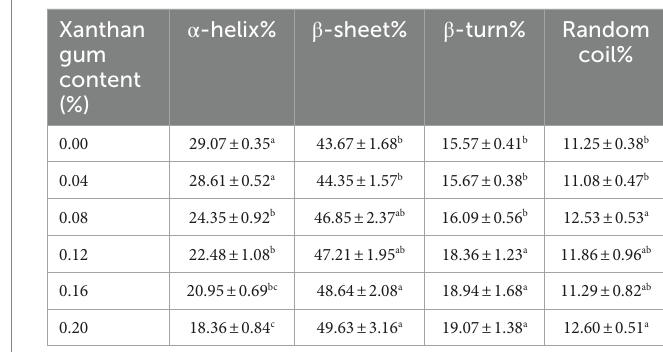
TABLE 4 Estimated secondary structure using the amide I region of SDEW protein